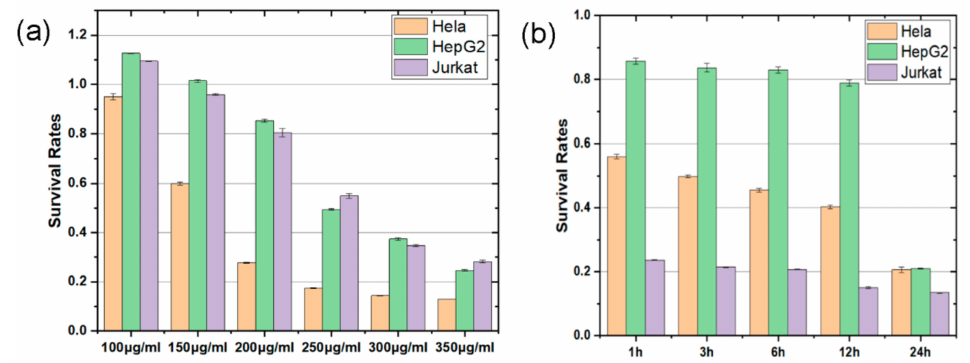
Figure 2. Survival rates of three types of cells treated with Rg3 at different ( a ) concentrations and ( b )